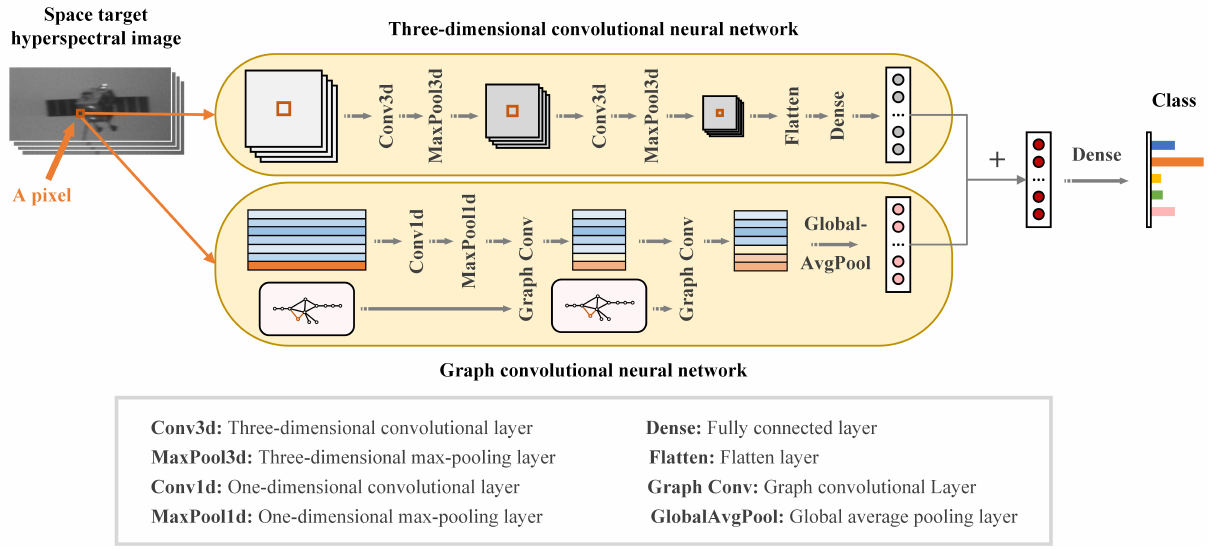
Figure 7. Flowchart for building the topological graph of the space target global